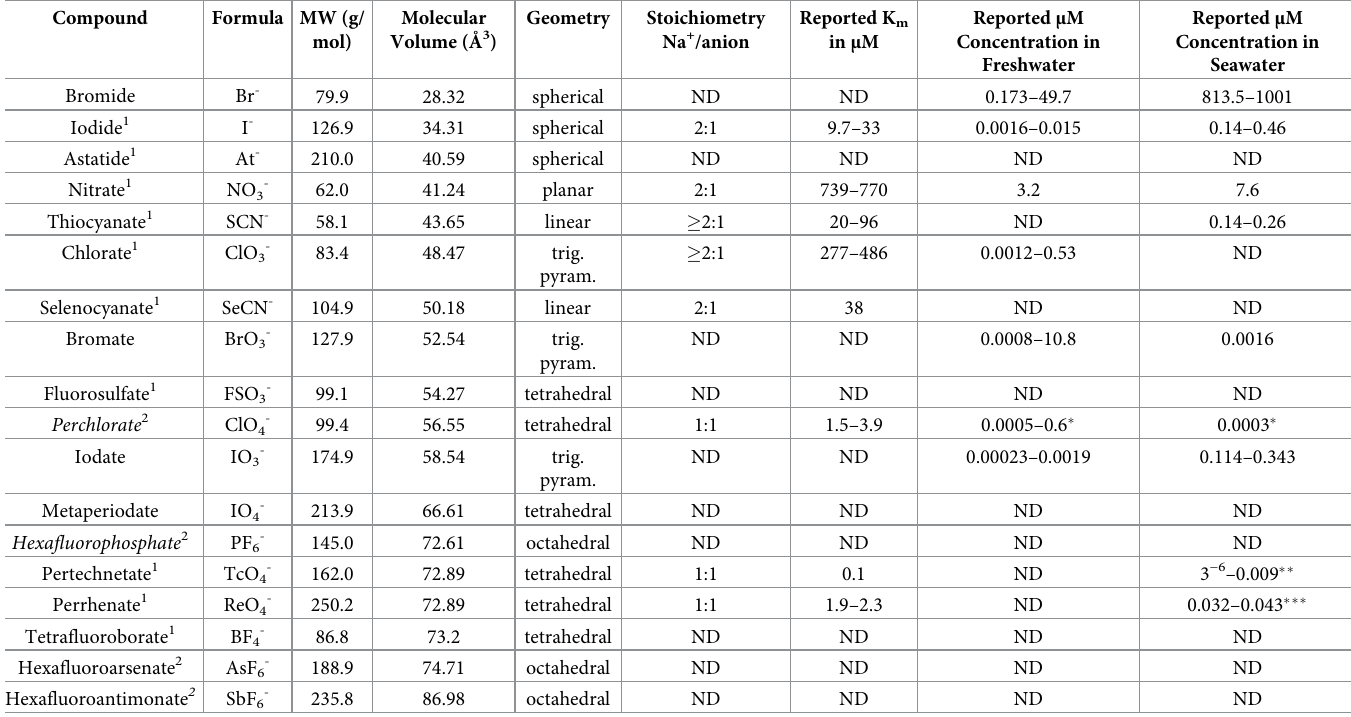
Table 1. Chemical and kinetic properties and environmental abundance of NIS substrates and